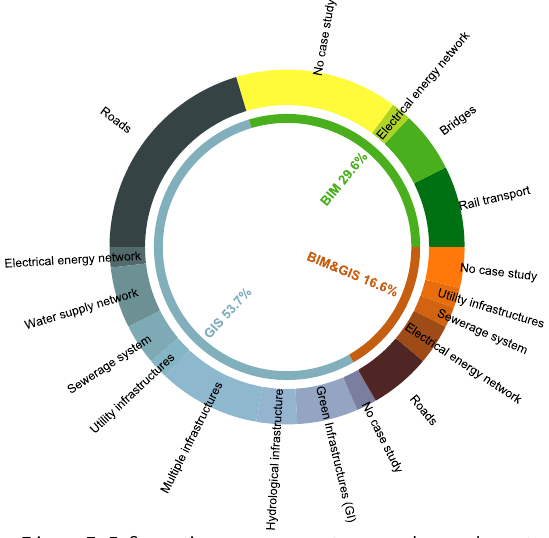
Figure 7. Information management approaches and